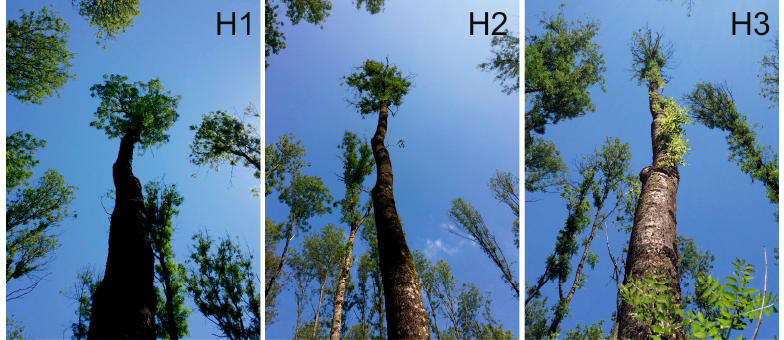
Figure 2. Three health groups according to crown defoliation (H1 = crown defoliation ≤ 25%; H2 = crown defoliation 26–60%; H3 = crown defoliation 61–99%).